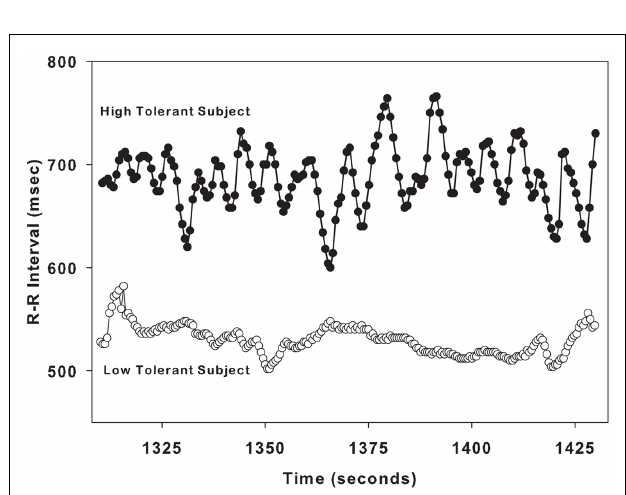
The number of subjects at the subsequent time points during LBNP decline as subjects experience presyncopal symptoms at various levels of LBNP. Data are shown as mean ± SE. ∗ Denotes group differences at the same LBNP level ( p ≤ 0.05).